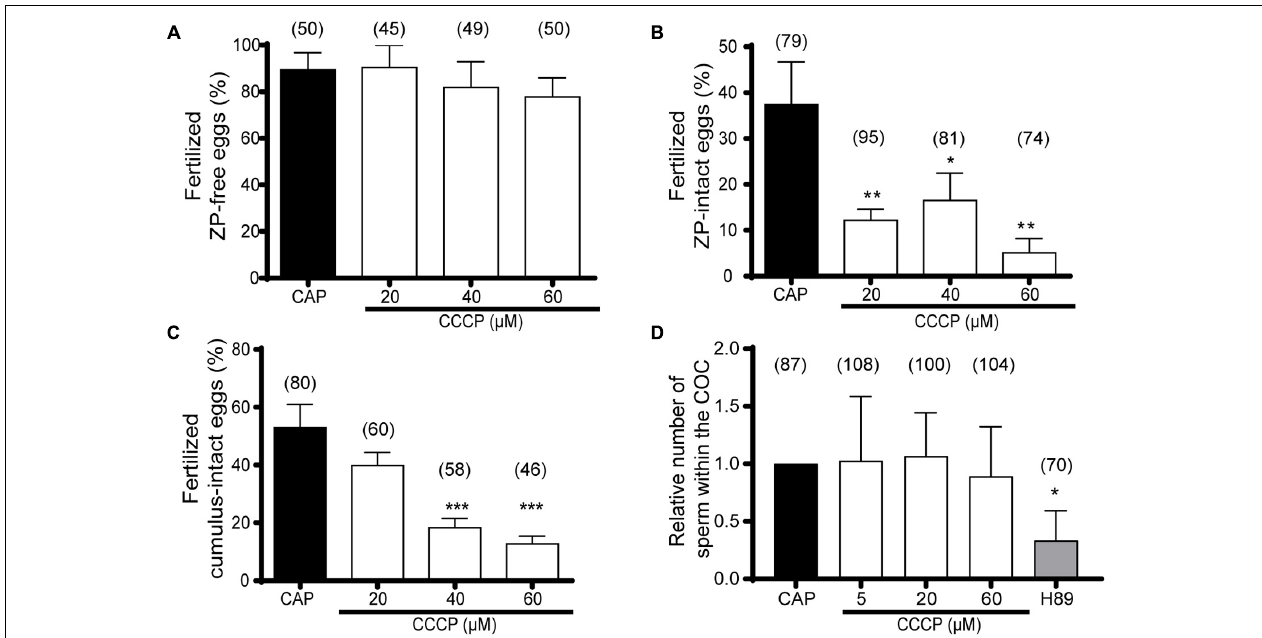
FIGURE 5 | Relevance of mitochondrial activity on mouse sperm in vitro fertilizing ability. (A–C) Epididymal sperm were incubated in the capacitation medium containing CCCP (20–60 µ M) or DMSO (capacitated sperm, CAP), and used to inseminate (A) ZP-free eggs ( n = 4), (B) ZP-intact eggs ( n = 5) or (C) cumulus-intact eggs ( n = 4). The percentage of fertilized eggs was determined in all cases. (D) Epididymal sperm were incubated in the capacitation medium containing CCCP (5–60 µ M), H89 (20 µ M), or DMSO (capacitated sperm, CAP), loaded with Hoechst 33342, and used to inseminate cumulus-intact eggs. After 15 min, the number of bright sperm heads within the cumulus matrix was determined. Results representing the relative numbers to the capacitated group are shown ( n = 6). In brackets is indicated the total number of analyzed eggs per treatment. Results are expressed as mean ± SEM for (A–C) and median with interquartile range for (D) . * p < 0.05, ** p < 0.01, *** p < 0.001.